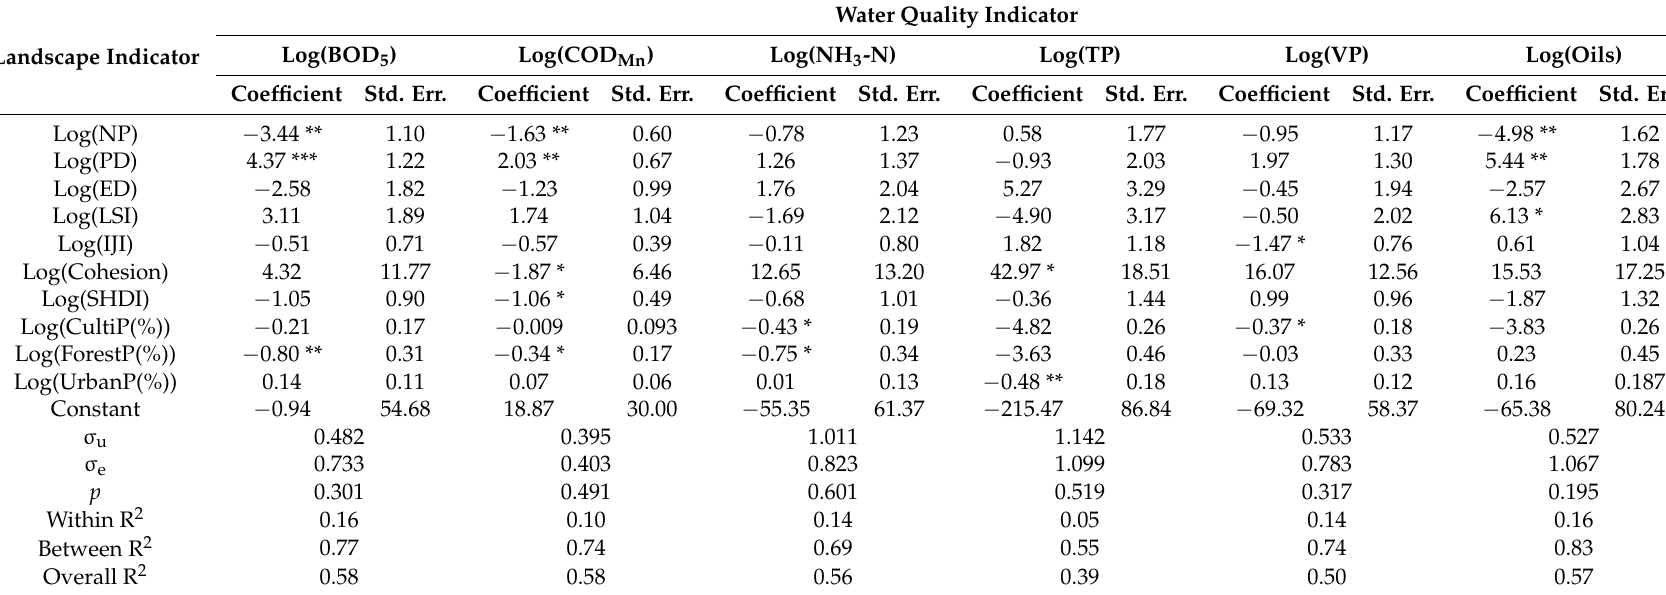
Table 2. Relationships between water quality and landscape changes via fixed-effects panel regression analysis using log-log variables.